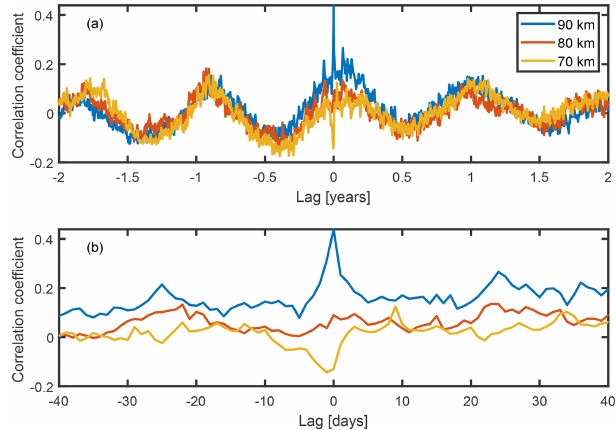
Figure 11. Correlation coefficients between daily averaged AE in- dex and zonal wind variance observed at Halley shown at a range of lag times. Panel (a) shows the long-term correlation: the sinu- soidal nature of the correlation shows a seasonal cycle. Peaks are seen at zero lag at 70 and 90km, suggesting a relationship beyond the seasonal variations. In panel (b) , the central peaks are shown. A distinct correlation at zero lag is seen for some altitudes, positive at 90km and negative at